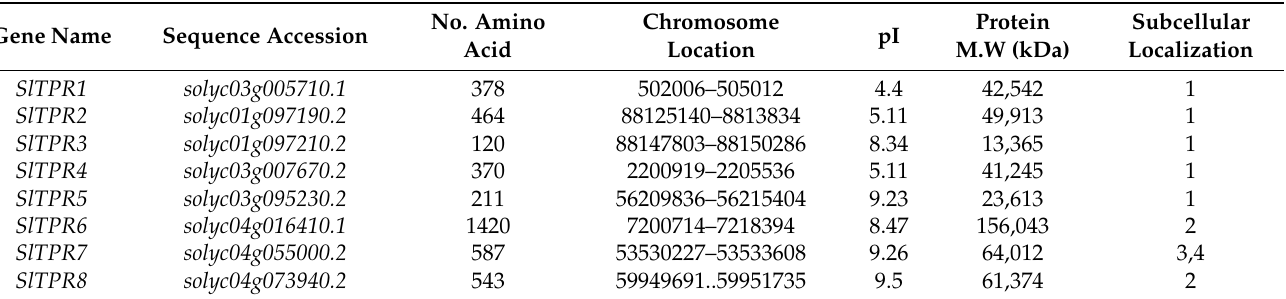
Table 1. Information of TPR gene family in